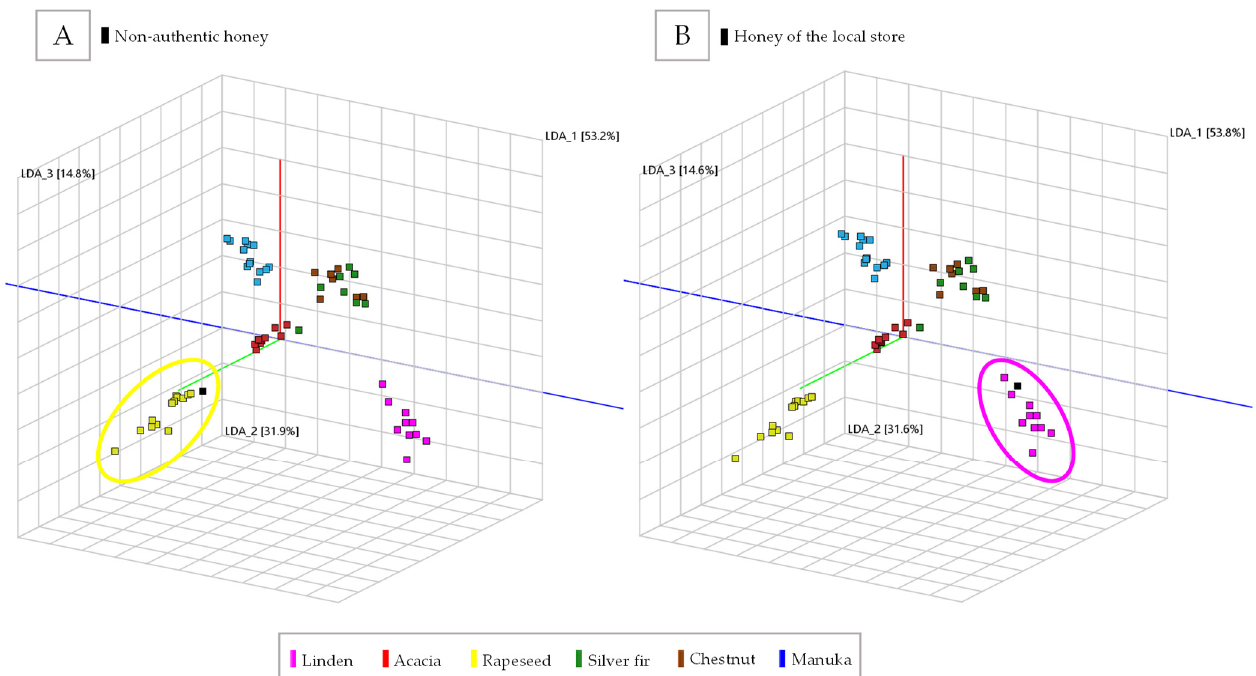
Figure 5. Three-dimensional visualization of the PCA-LDA of the honey data set with samples grouped by color as honey type (linden = pink, acacia = red, rapeseed = yellow, silver fir = green, chestnut = brown, and manuka = blue). ( A ) shows the PCA-LDA with the non-authentic honey, which can be classified as rapeseed honey (yellow circle). ( B ) displays the classification of the honey from the local store, which can be classified as linden honey (pink circle).